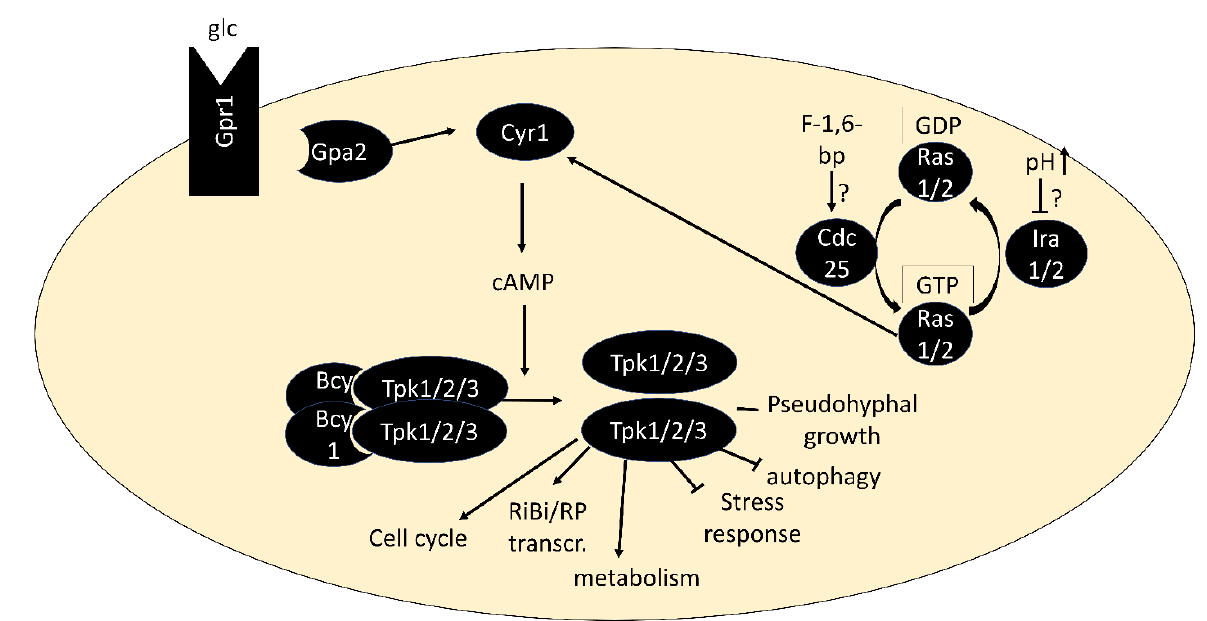
Figure 1. Core components of the PKA pathway. In its inactive form, PKA exists as a tetramer of two regulatory subunits (Bcy1) and two catalytic subunits (Tpk1, Tpk2 or Tpk3). Binding of cAMP to Bcy1 leads to dissociation of the complex and activation of the catalytic subunits. Two main routes of activation of adenylate cyclase Cyr1 exist: via the G protein-coupled receptor Gpr1 and its G protein alpha subunit Gpa2 and via the small GTPases Ras1/2.